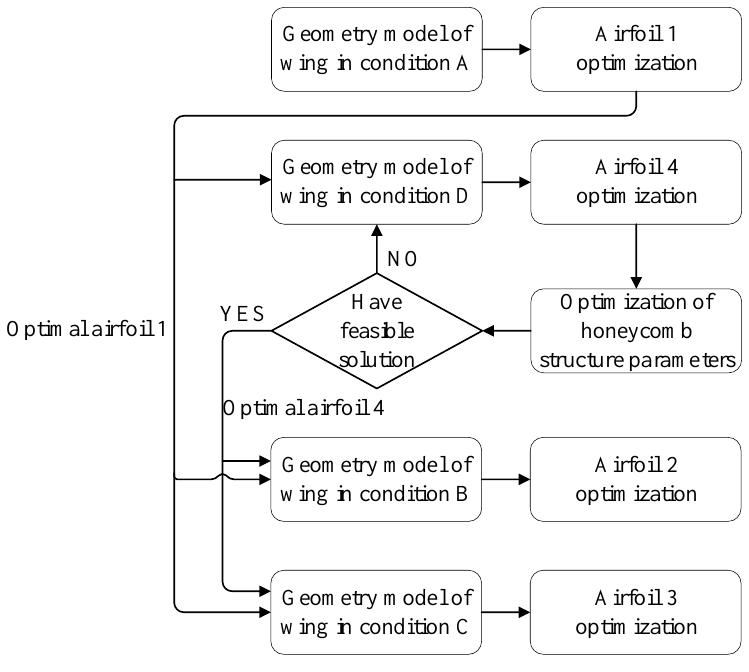
Figure 8. Optimization